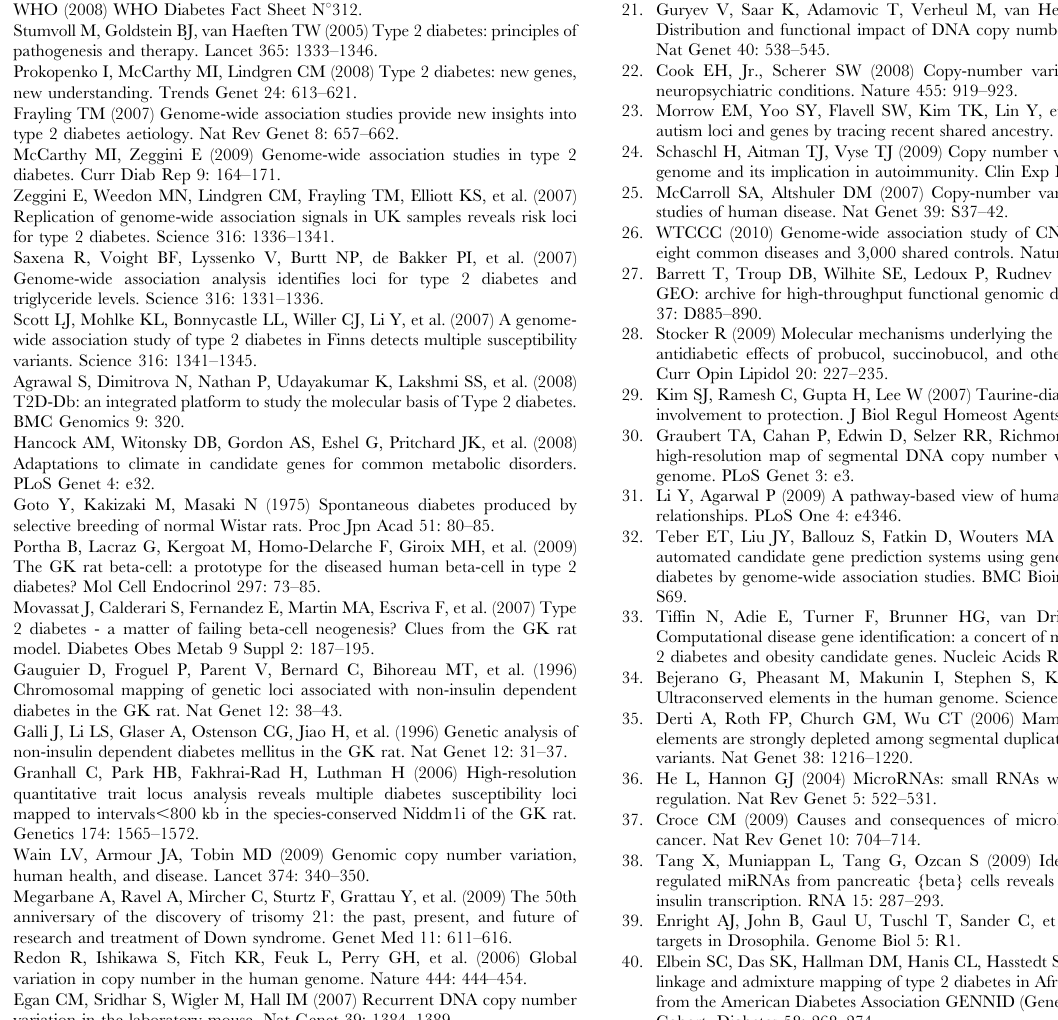
Table S13 Comparison of CNV genes and differentially expressed